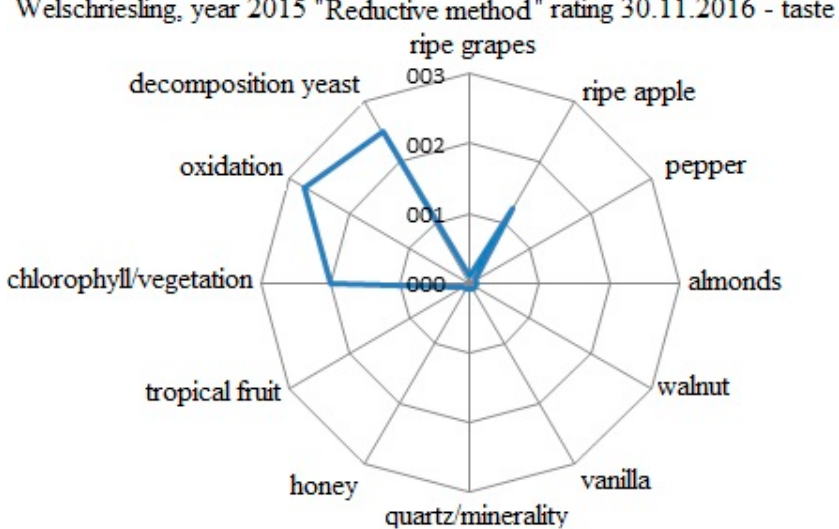
Figure4. Figure 4. Evaluation of the specific taste descriptors for the W 2015 variant processed by the reductive method.